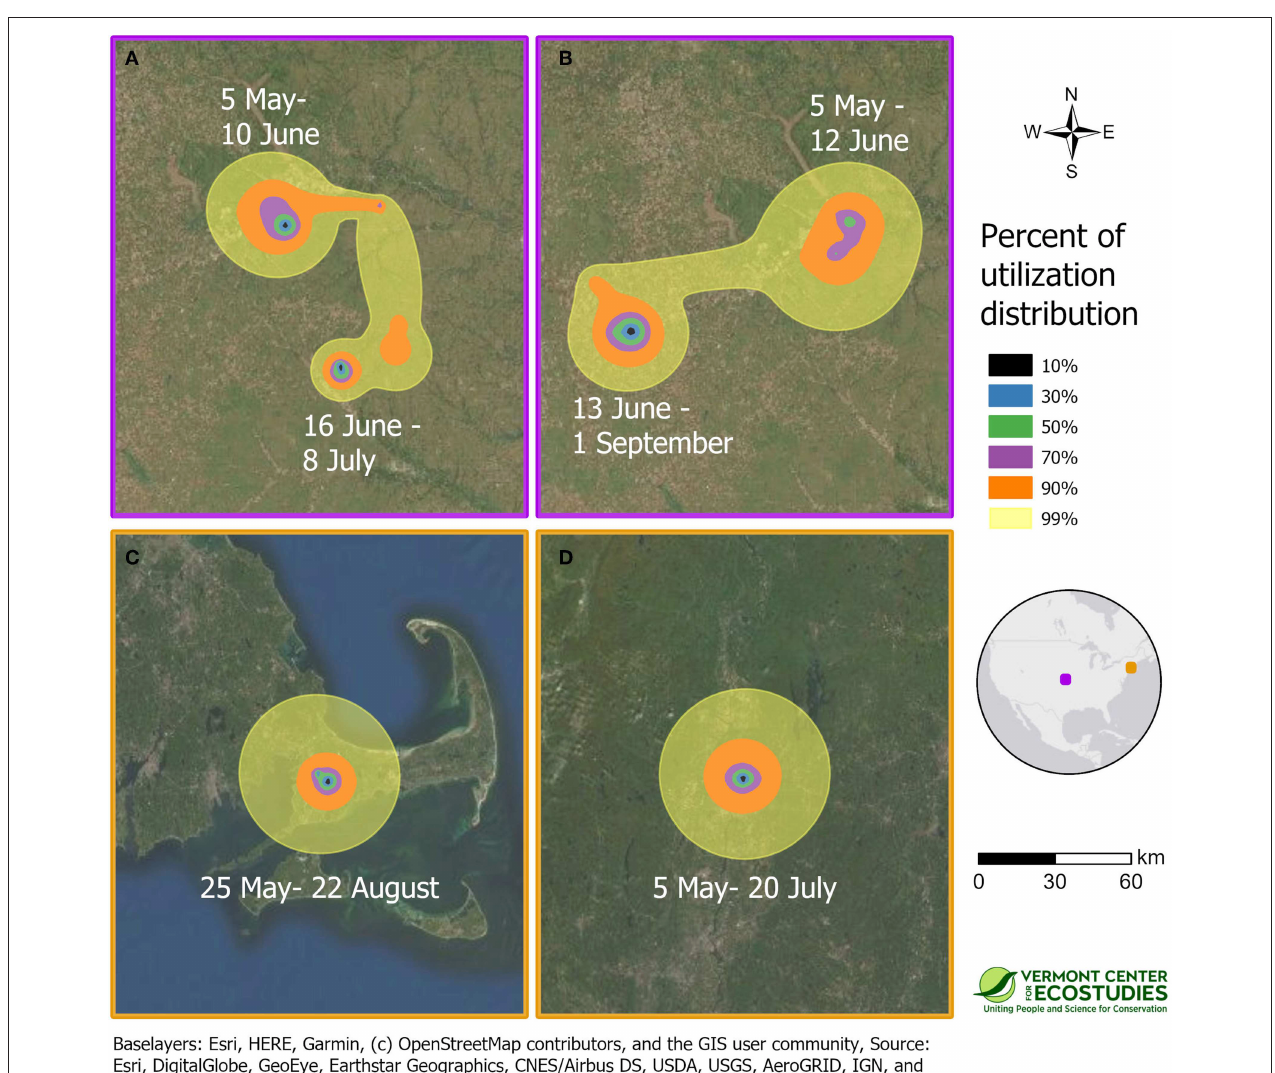
FIGURE 2 | Space use on the breeding grounds during the summer of 2016 for four sandpipers marked with PTT transmitters at tallgrass prairie sites in Kansas [KO-PTT-66 (A) and KO-PTT-69 (B) ], and prairie remnants in Massachusetts [JB-PTT-67 (C) and WO-PTT-68 (D) ]. Approximate 99% utilization distributions indicate probability of use for each sandpiper throughout the breeding period, and were calculated using dynamic Brownian bridge movement models. The border color of a panel indicates its location on the inset map, and all panels are shown at the same spatial